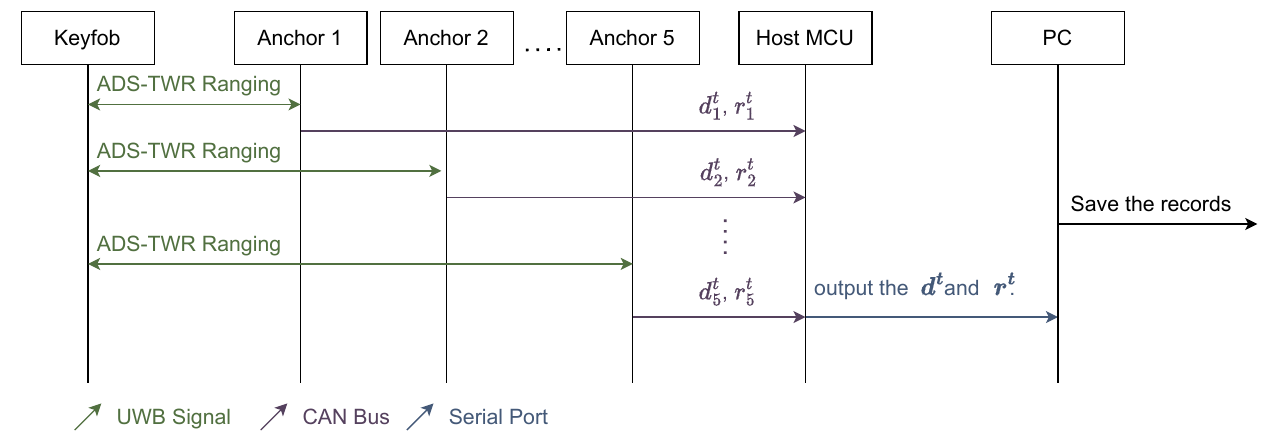
Figure 4. The flow chart of the localization procedure in our KES system.